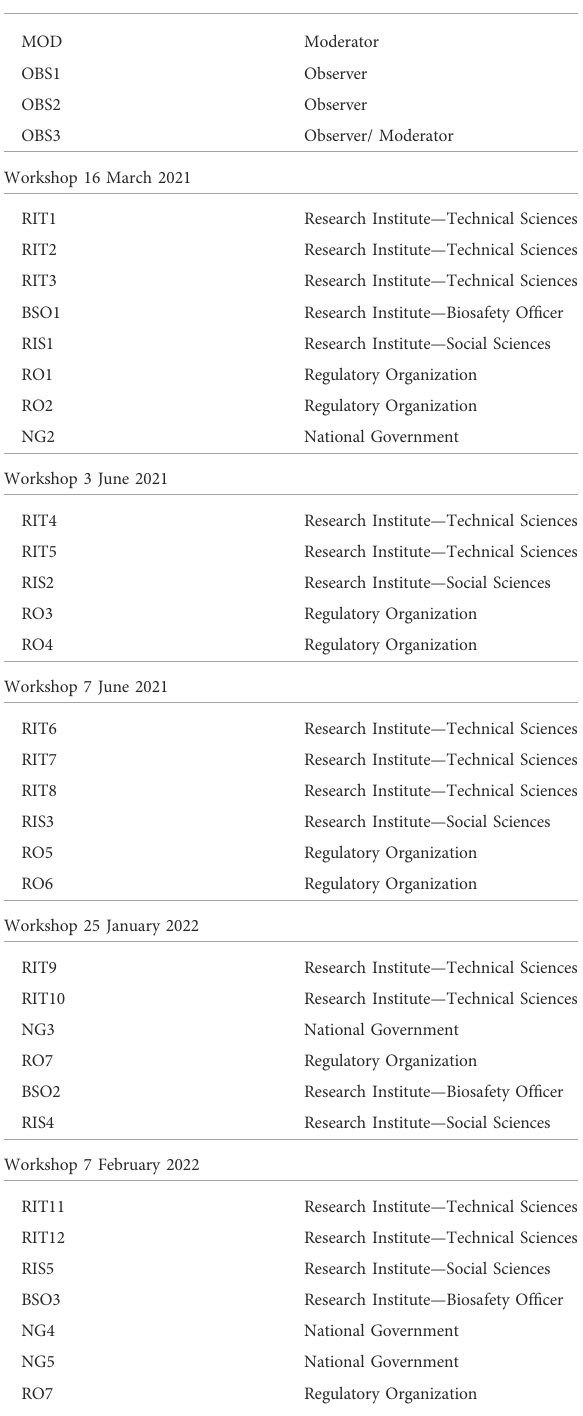
TABLE 3 Participants ’ Sectors and